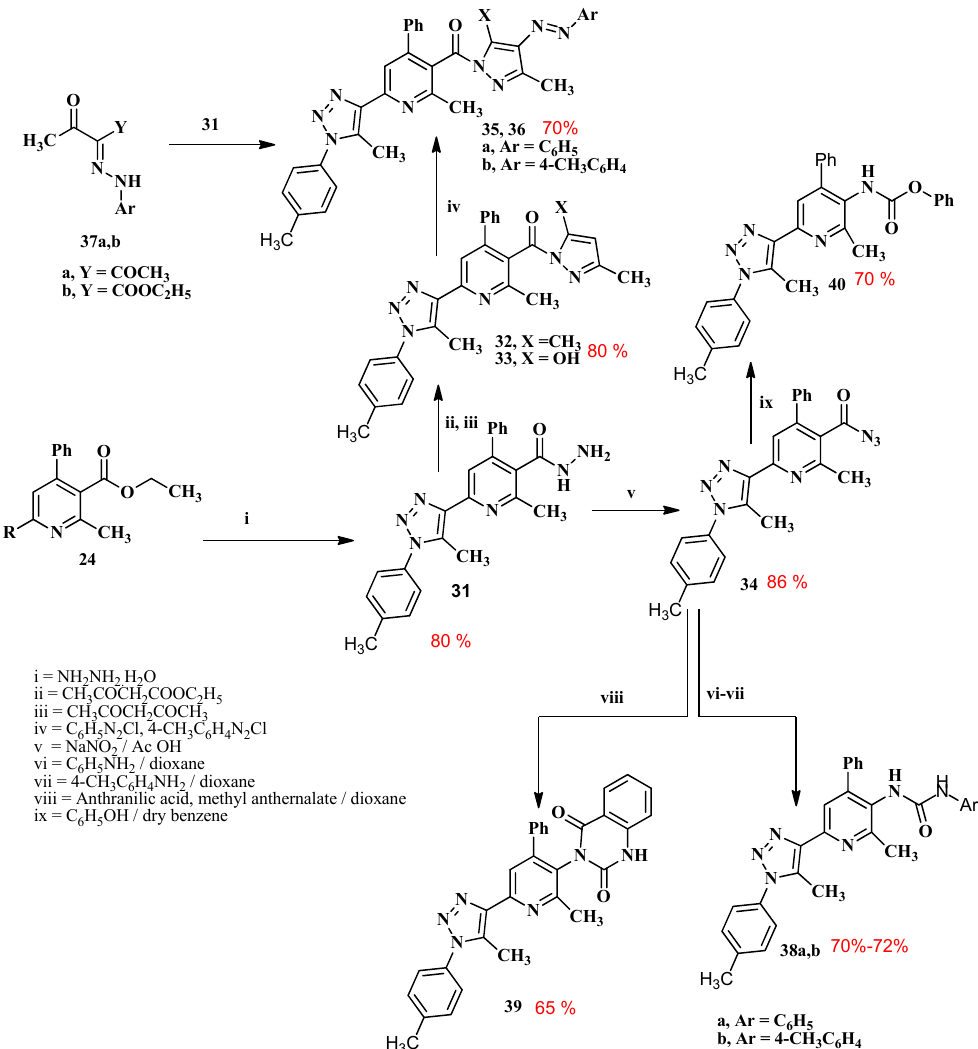
Scheme 6. Synthesis of pyrazoles, urea, quinazoline and